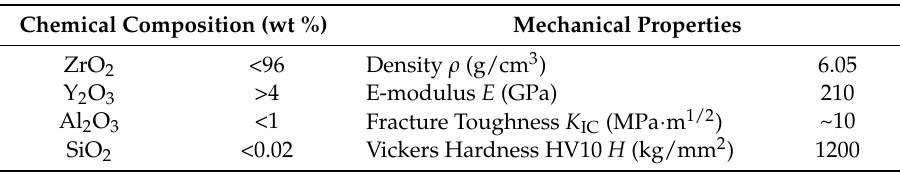
Table 1. Chemical composition and mechanical properties of the workpiece